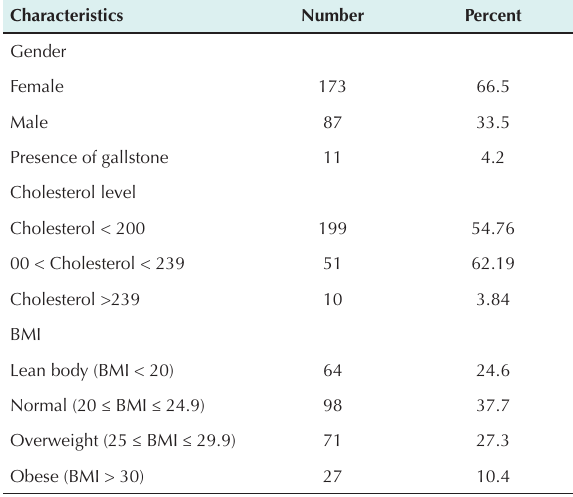
Table 1. Demographic, Laboratory Results of the Celiac Disease Characteristics